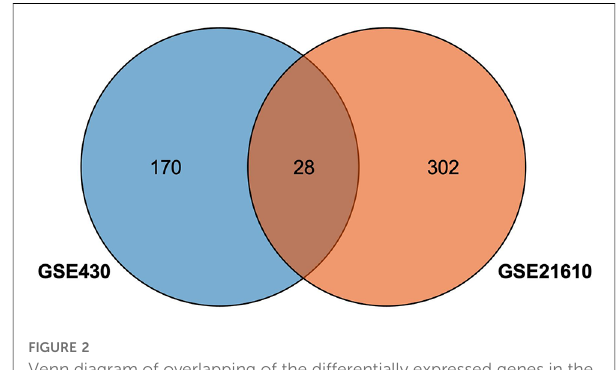
FIGURE 2 Venn diagram of overlapping of the differentially expressed genes in the datasets.